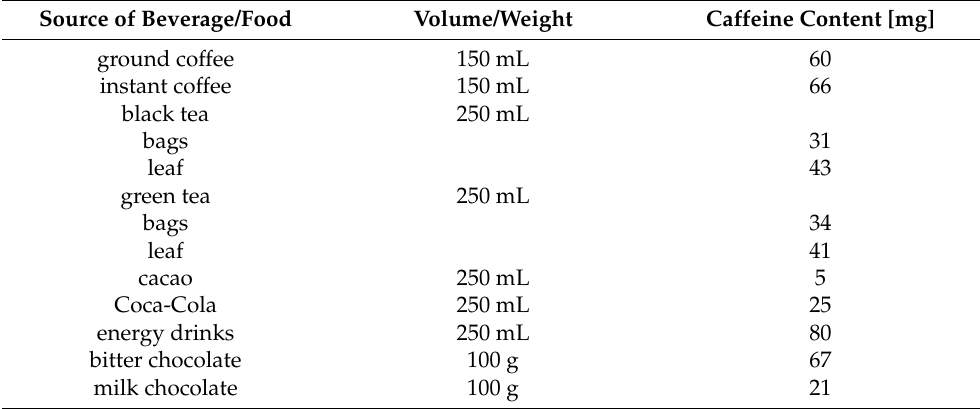
Table 1. Caffeine content in different beverages and food products. Source: own elaboration based on: